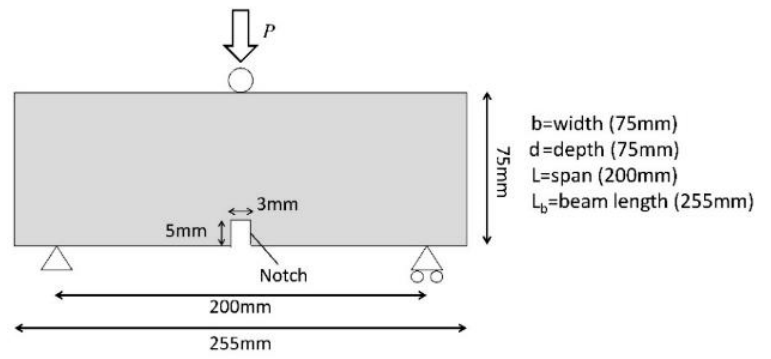
Figure 5. The three-point bend test arrangement.